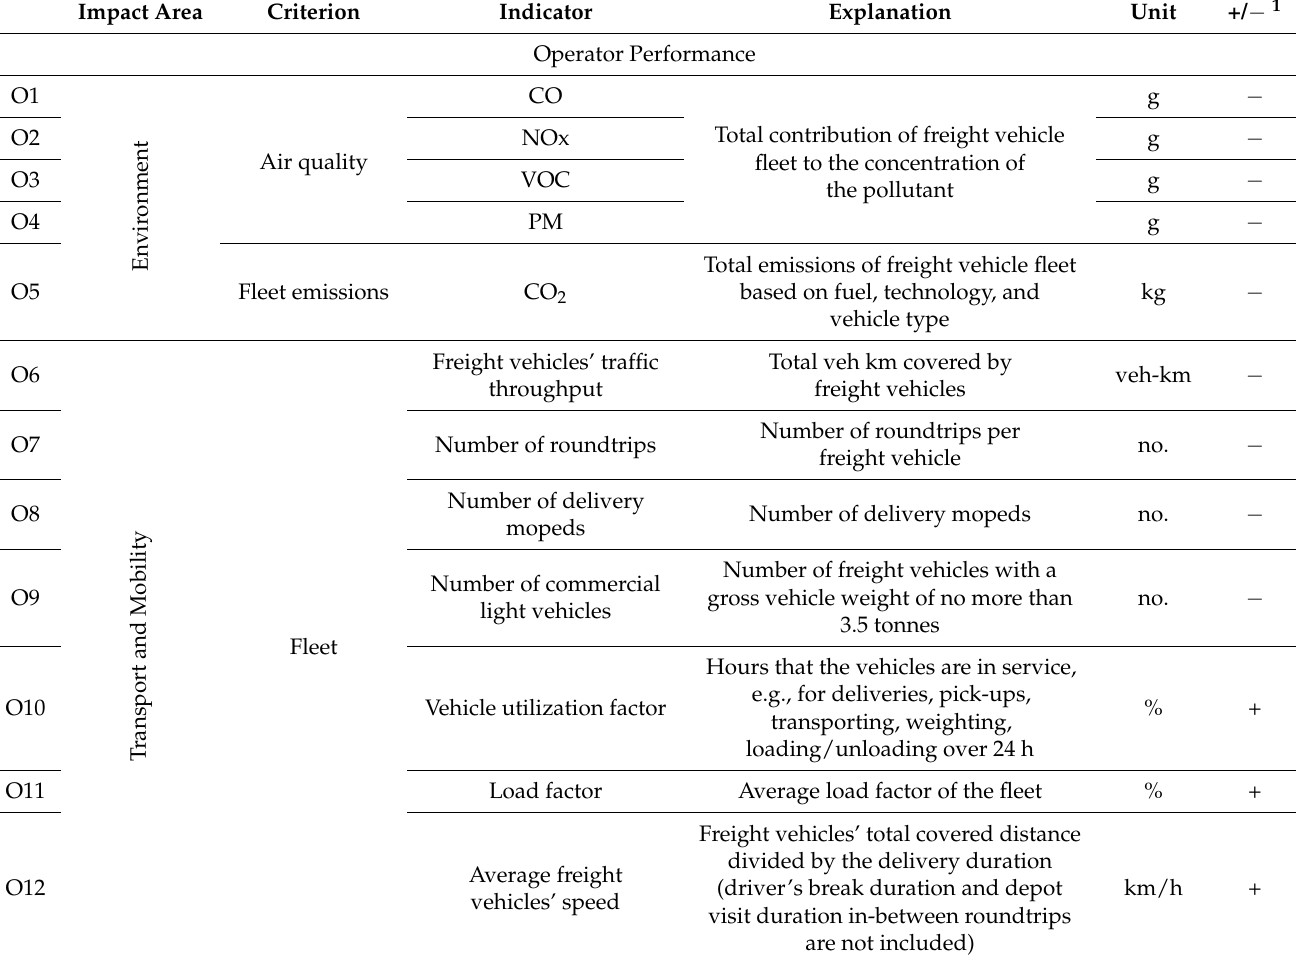
Table 5. List of evaluation components: Operator and network performance. Impact